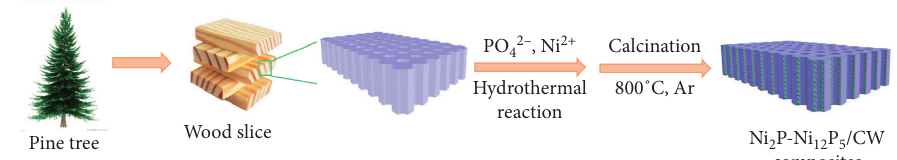
Figure 1: Schematic illustration of preparing the Ni